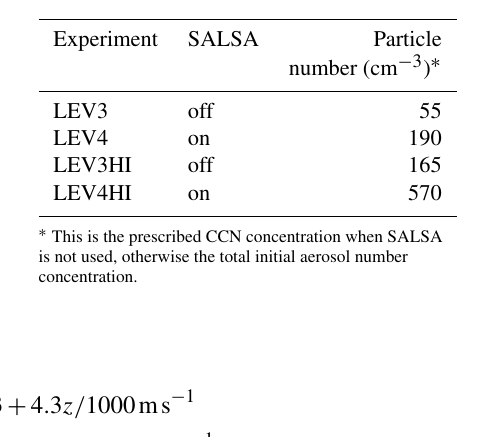
Table 1. The DYCOMS-II model experiments with their key con- figuration